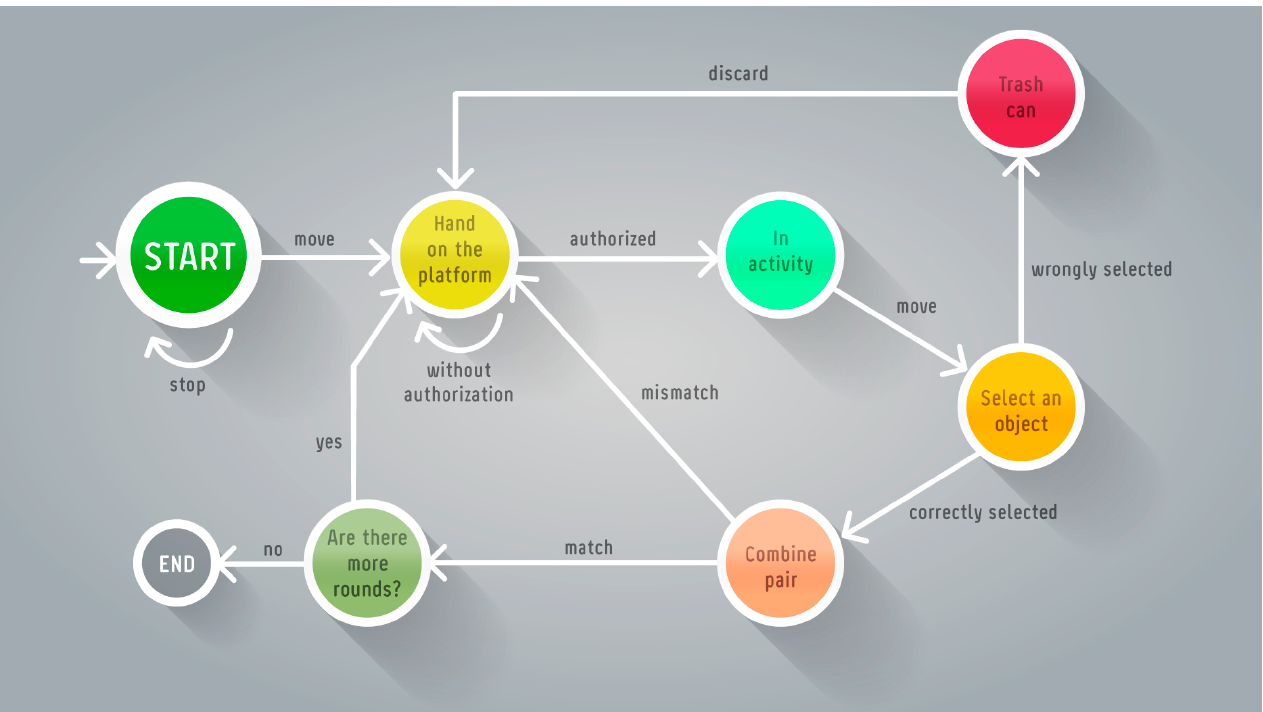
Figure 2: State diagram of AGaR.